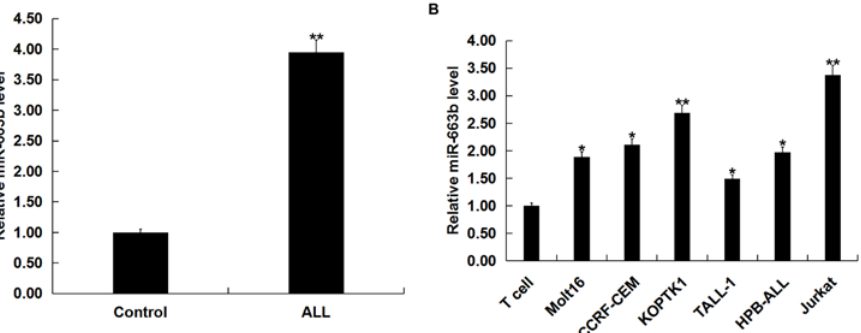
Figure 1: MiR-663b was up-regulated in human T-ALL cell lines and blood of pediatric T-ALL patients. (A) qRT-PCR assay detected the relative expression level of miR-663b in blood of 30 cases pediatric T-ALL patients (ALL) and 30 cases healthy children (Control) (**p<0.01 vs. Control). (B) qRT-PCR assay detected the expression level of miR-663b in different human T-ALL cell lines and normal T cells. The data were expressed as the mean ± SD. *,**p<0.05, 0.01 vs. T cell.